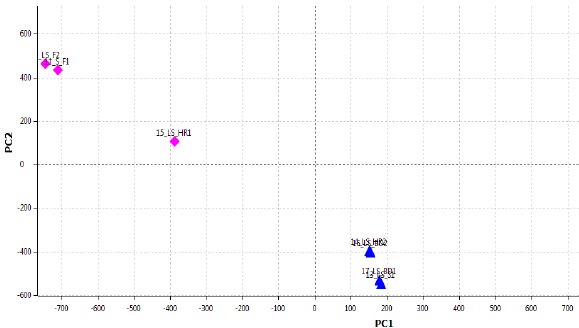
Figure 1: The score plot of PCA model using fatty acid composition of beef fat in SO, FO, BD, and